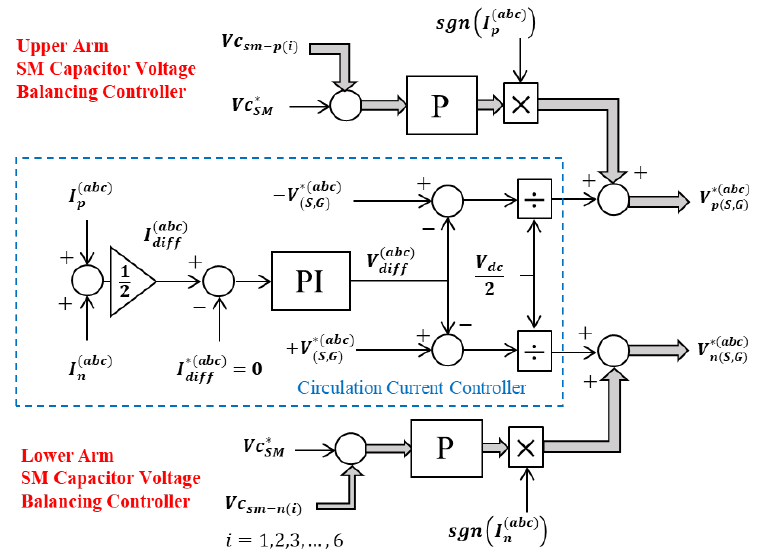
Figure 10. MMC Inner